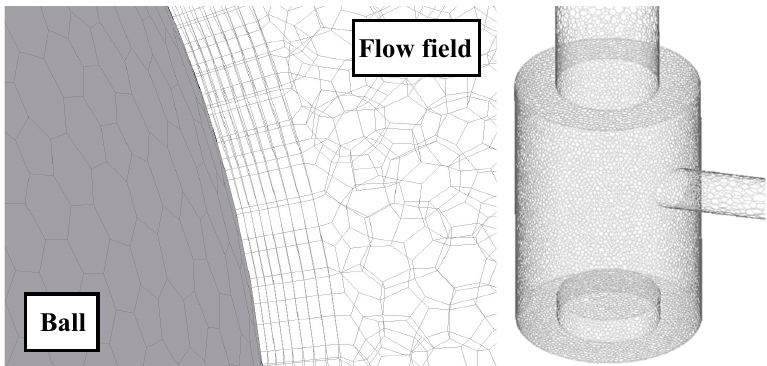
Figure 2. Mesh arrangement around the check ball and housing.